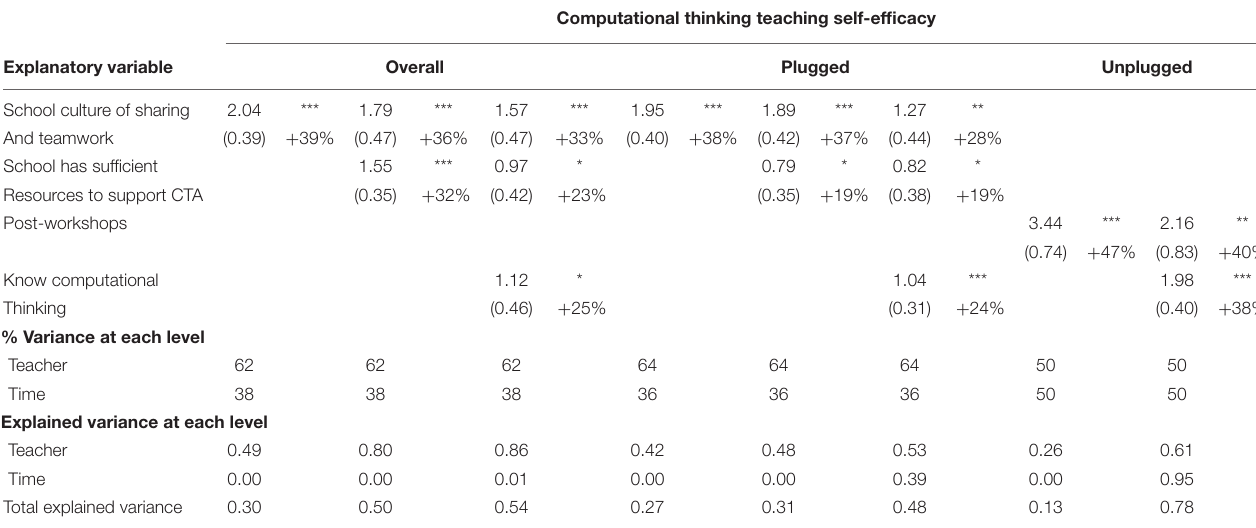
TABLE 5 | Summary of multilevel cross-classification analyses of overall / plugged / unplugged computational thinking teaching self-efficacy. Computational thinking teaching